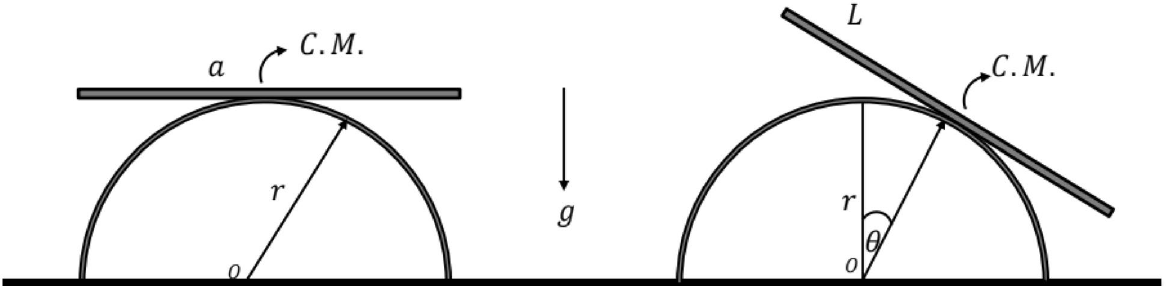
Figure 1. Sketches the model under